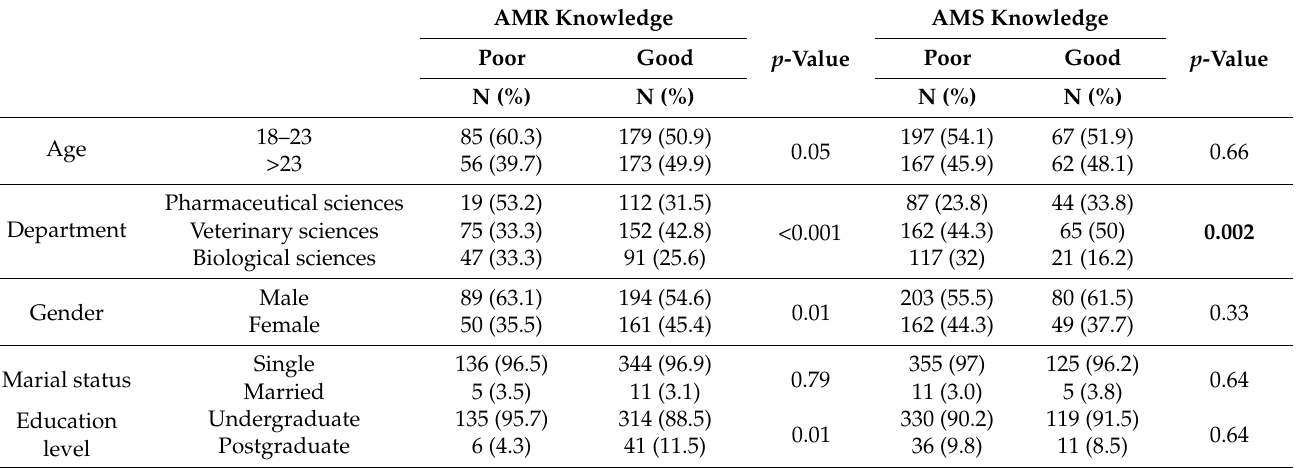
Table 6. Association of knowledge regarding antimicrobial resistance (AMR) and antimicrobial stewardship (AMS) with the demographics of the study